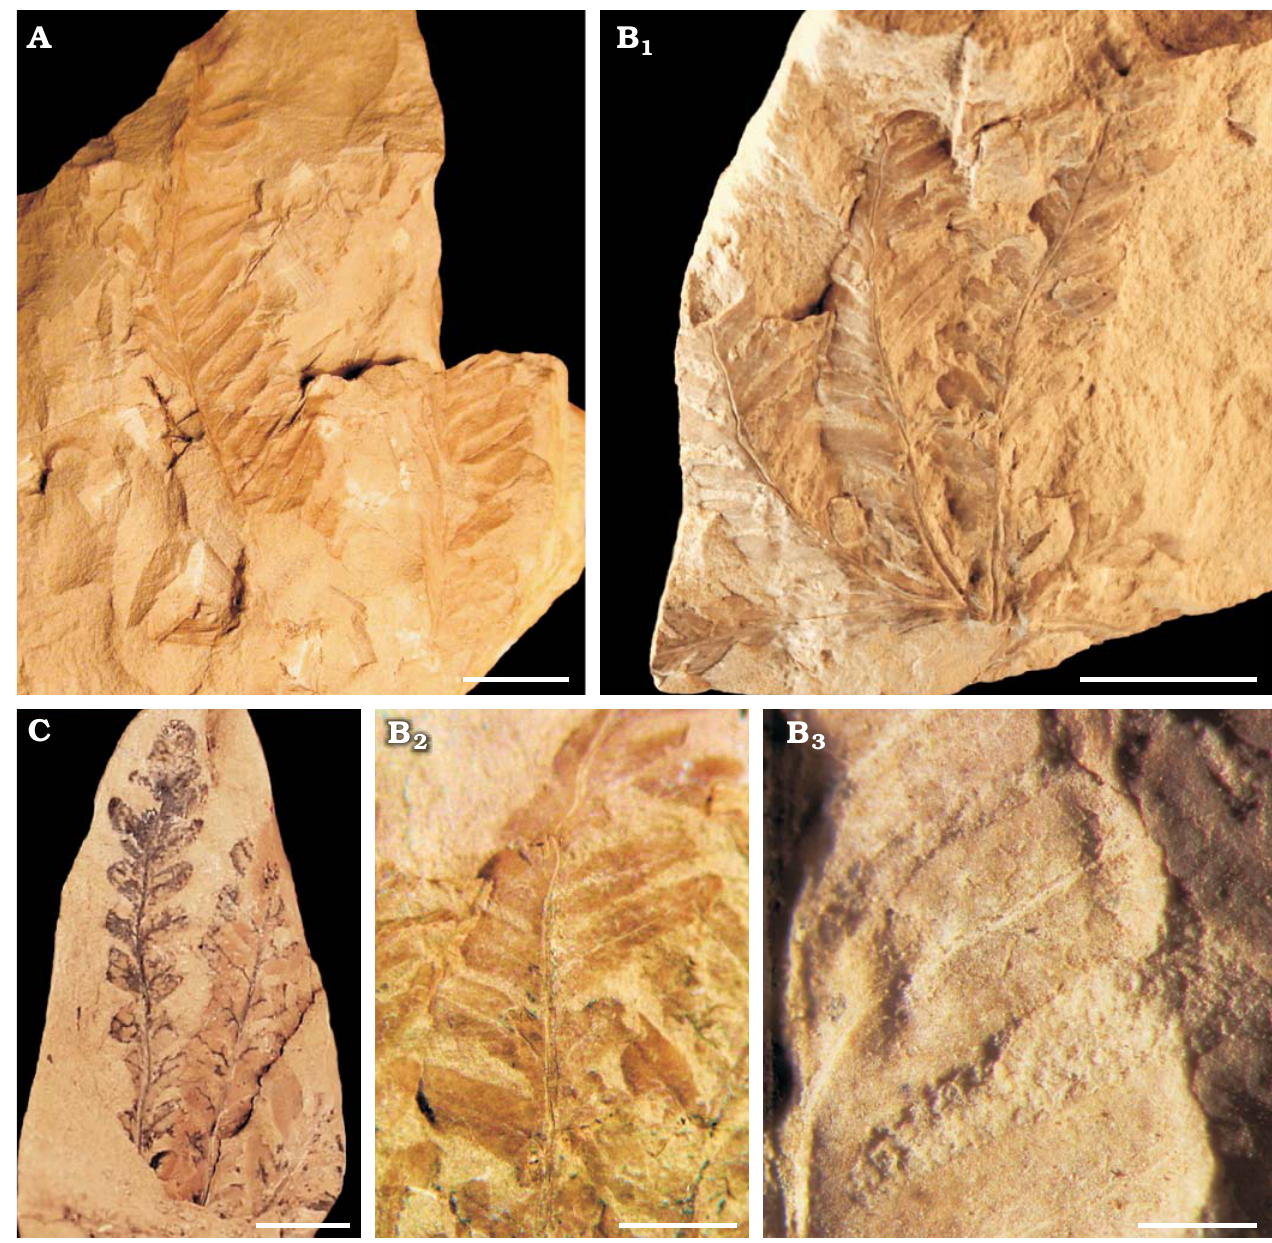
Fig. 7. Dipterid fern Thaumatopteris barrealensis Stipanicic and Menéndez, 1949 from Barreal Formation (Anisian, Middle Triassic) of Barreal-Calingasta, San Juan Province, Argentina. A . BAPb 6263. B . PBSJ 844; general view of the leaf (B 1 ), detail of the pinnulae (B 2 ), detail of the pinnula venation (B 3 ). C . PBSJ 849. Scale bars: A, B 1 , 10 mm; C, 5 mm; B 2 , 3 mm; B 3 , 1